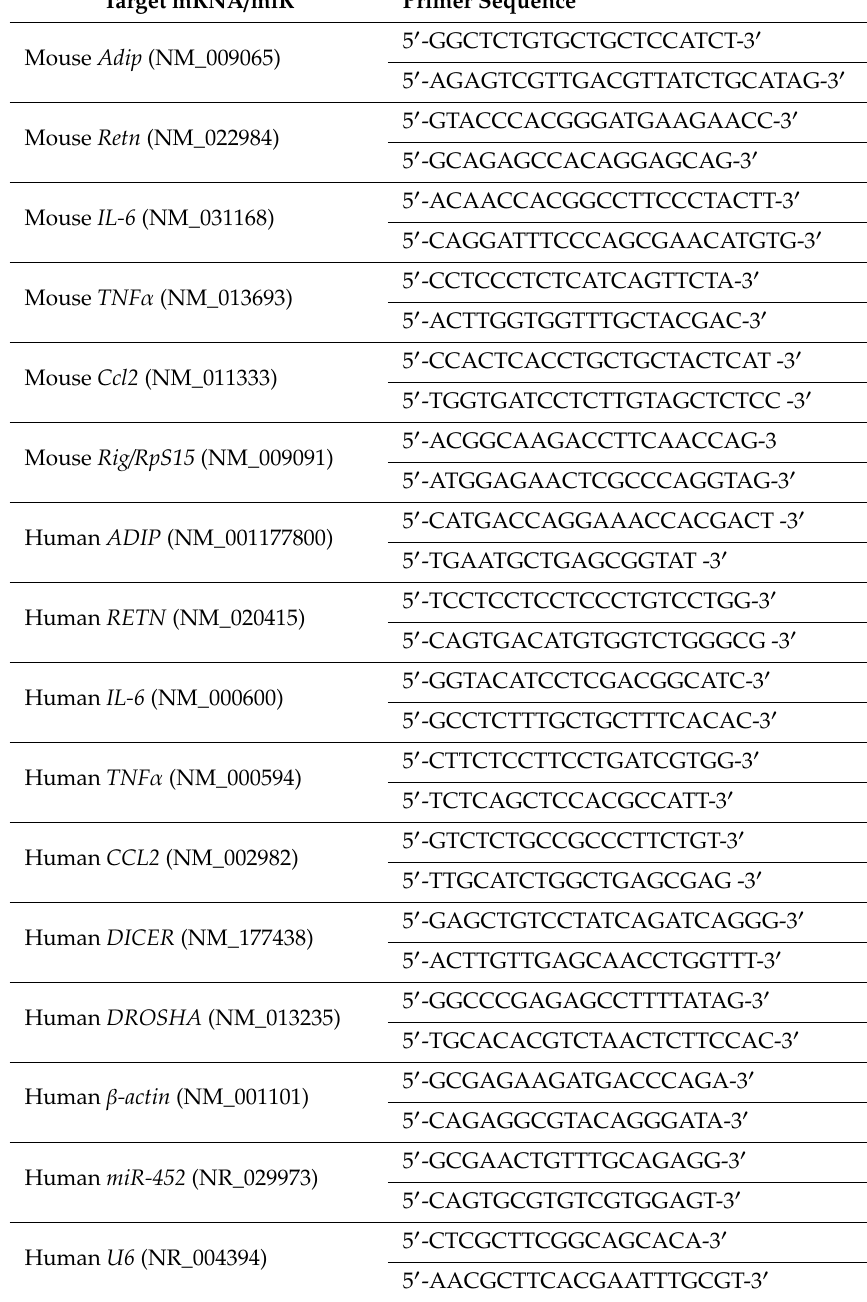
Table 1. Primers used for real-time